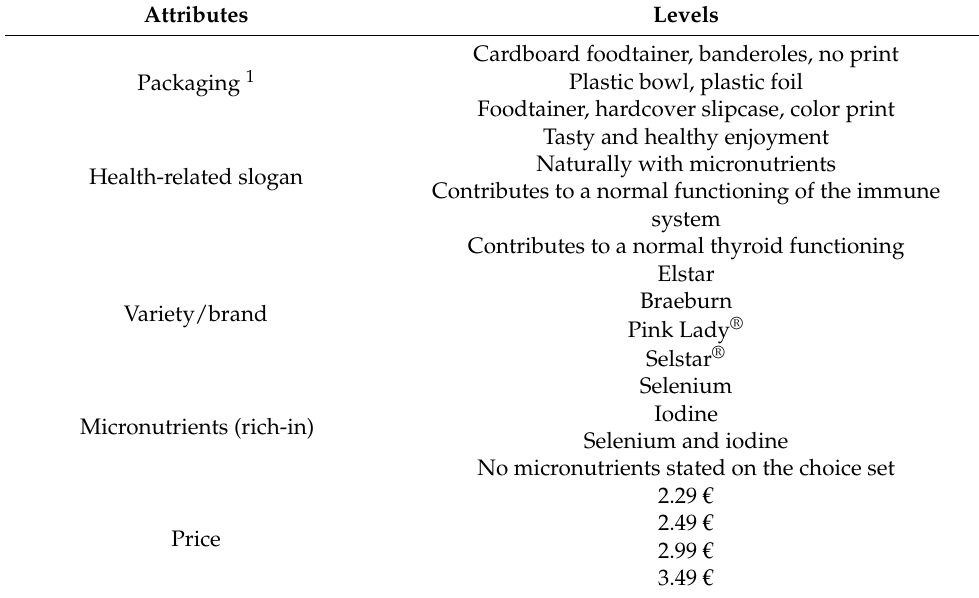
Table 1. Attributes and levels of the DCE.